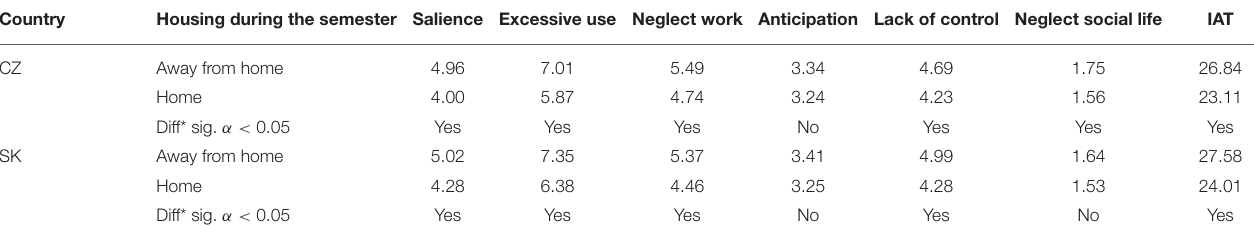
TABLE 7 | Mean values of the IAT and its subscales in the classification by housing during the semester. Country